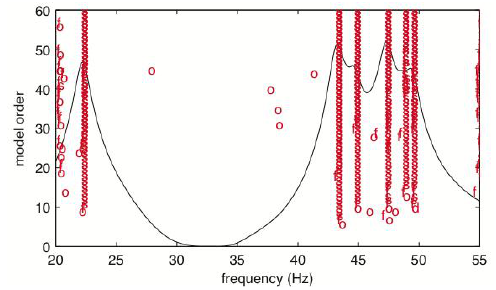
Fig. 5. Stabilisation diagram of an the FRFs (maximum order = 64).